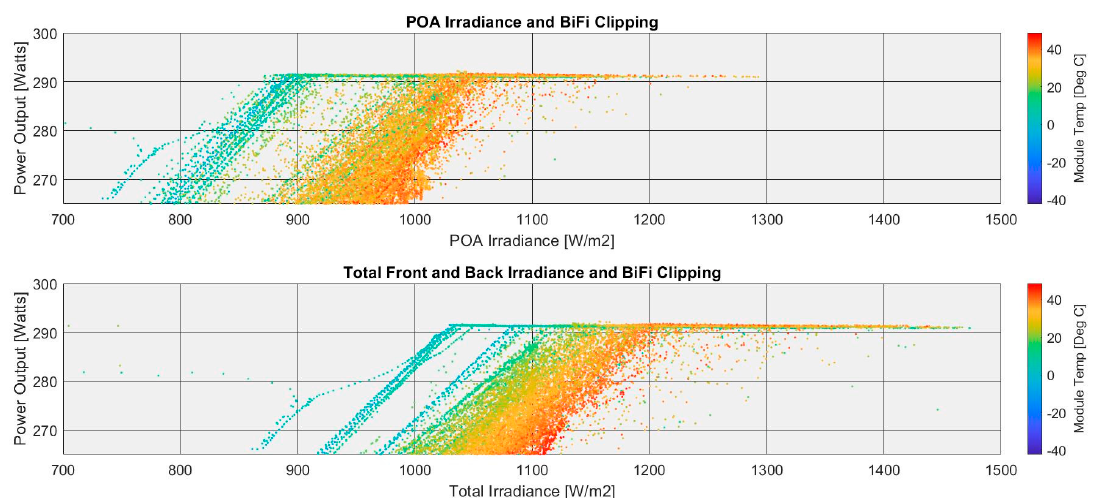
Figure 8. Scatter plots show the relationship between the power output, POA irradiance, and total irradiance calculated using Equation (3), as well as the module temperature.